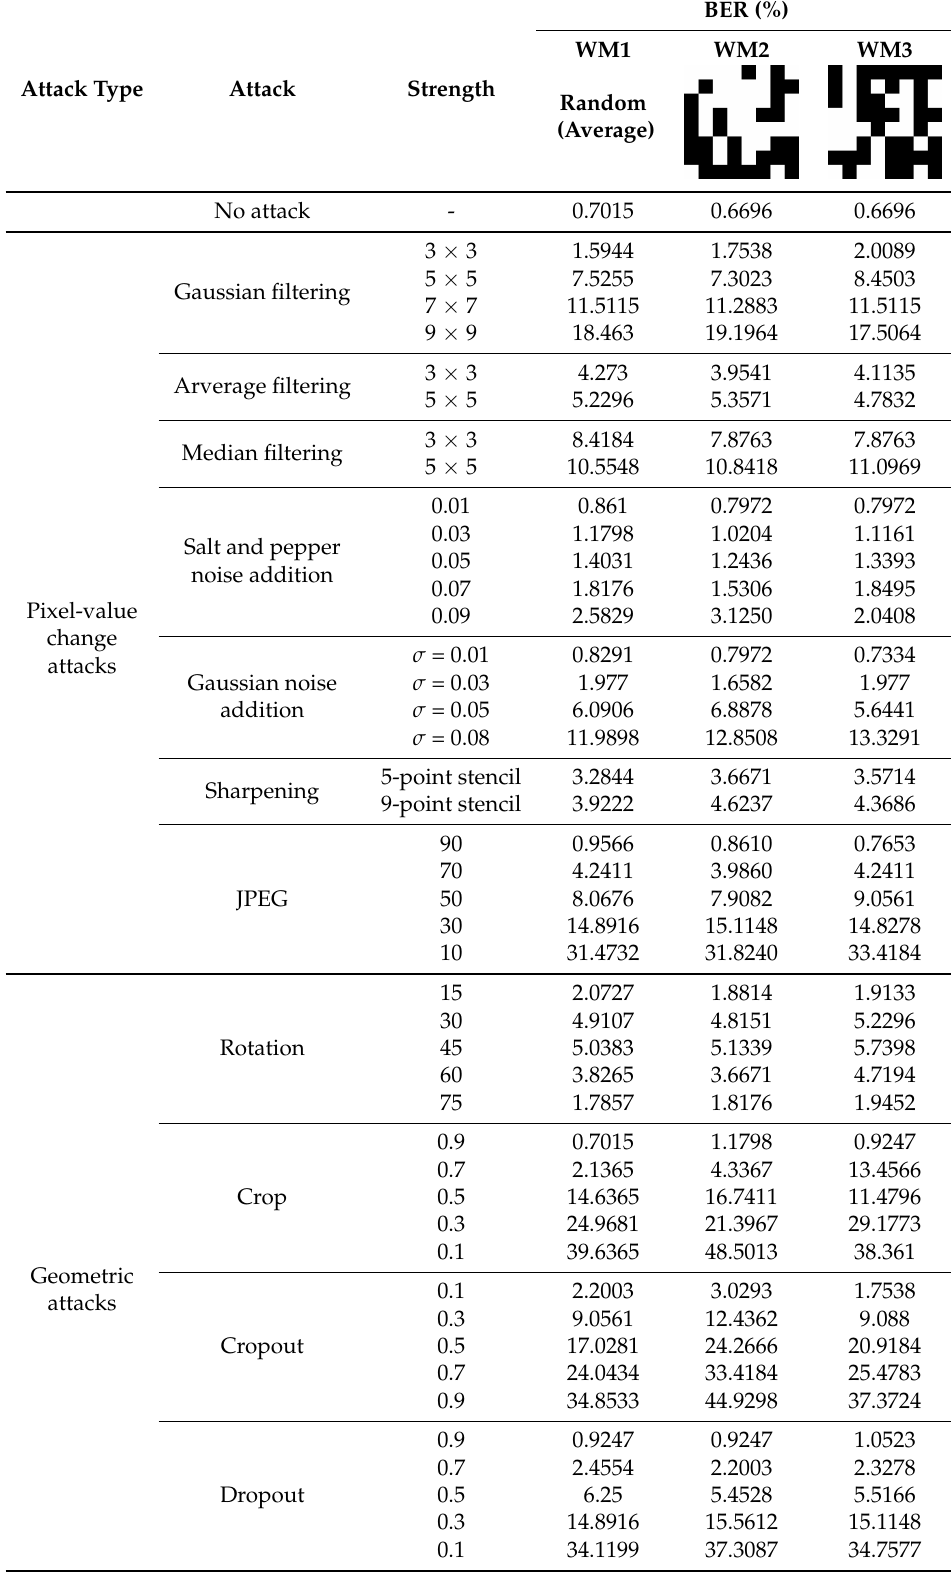
Table 4. Average bit error ratio (BER) values of extracted watermarks resulting from various